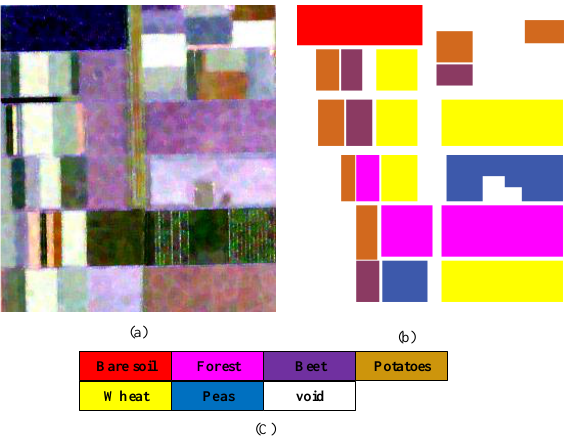
Figure 4. Fle. ( a ) Pauli RGB image. ( b ) GT. ( c ) Color code.